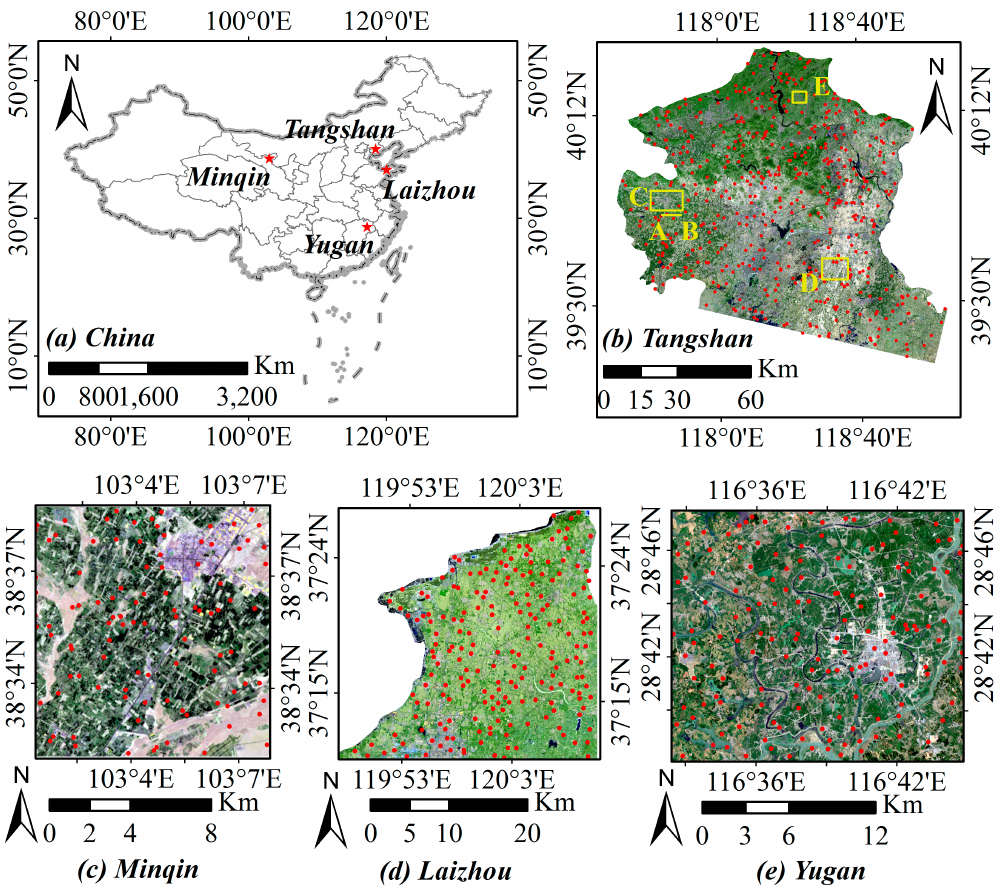
Figure 2. ( a ) Locations of experimental study area (Tangshan), and verification areas (Minqin, Laizhou, and Yugan), ( b ) 2016 Tangshan, ( c ) 2015 Minqin, ( d ) 2016 Laizhou; and ( e ) 2016 Yugan false color composites of bands 7, 6, and 4 (R, G, and B) with linear 2% stretch, and testing samples (red dots) for accuracy assessment in the four areas. Table 1. Study area situation and image list information.